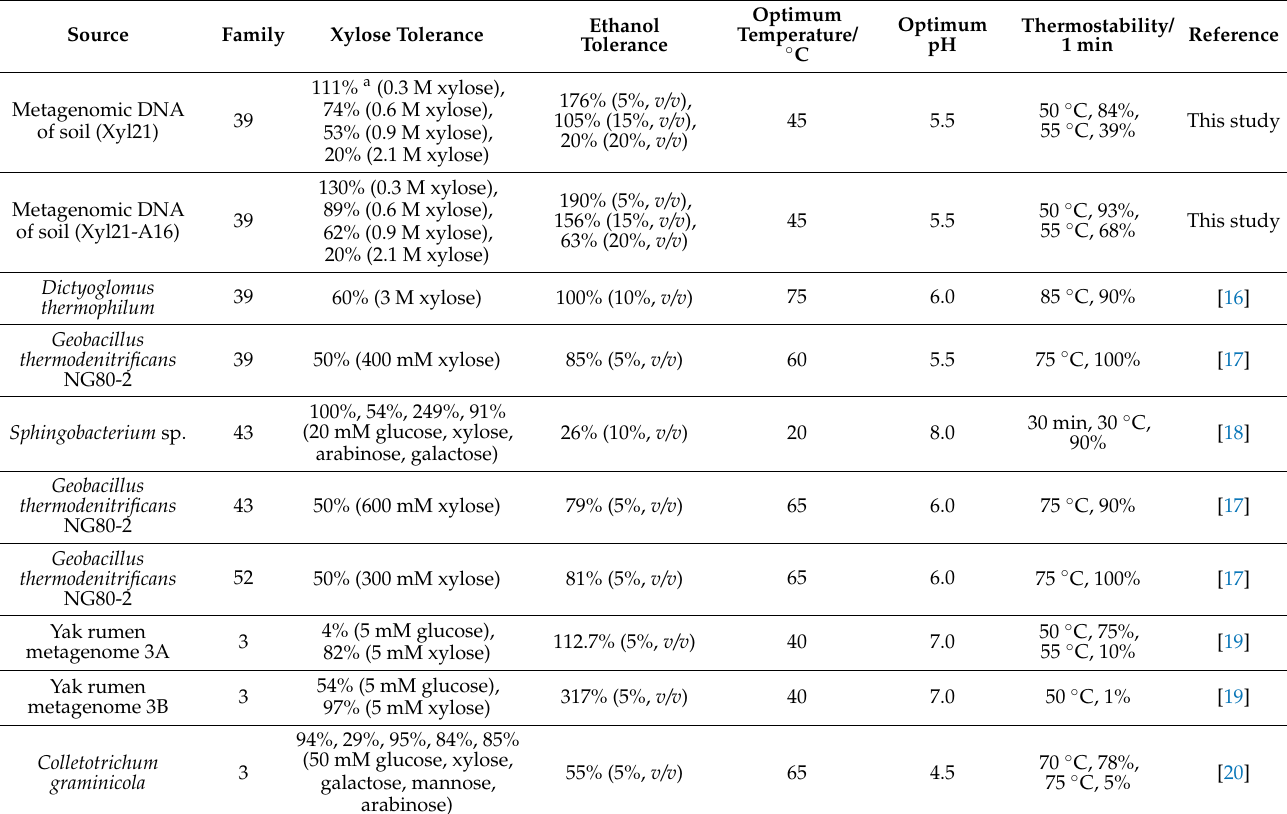
Table 1. The properties of representative β -xylosidases from different glycosyl hydrolase